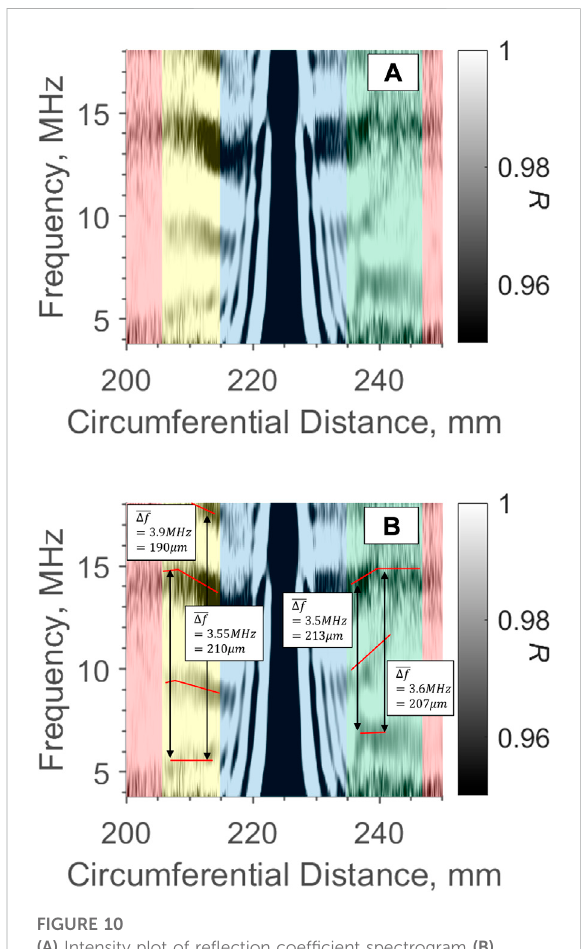
FIGURE 10 (A) Intensity plot of re fl ection coef fi cient spectrogram (B) same plot with estimated frequency value for indication of fi lm thickness.